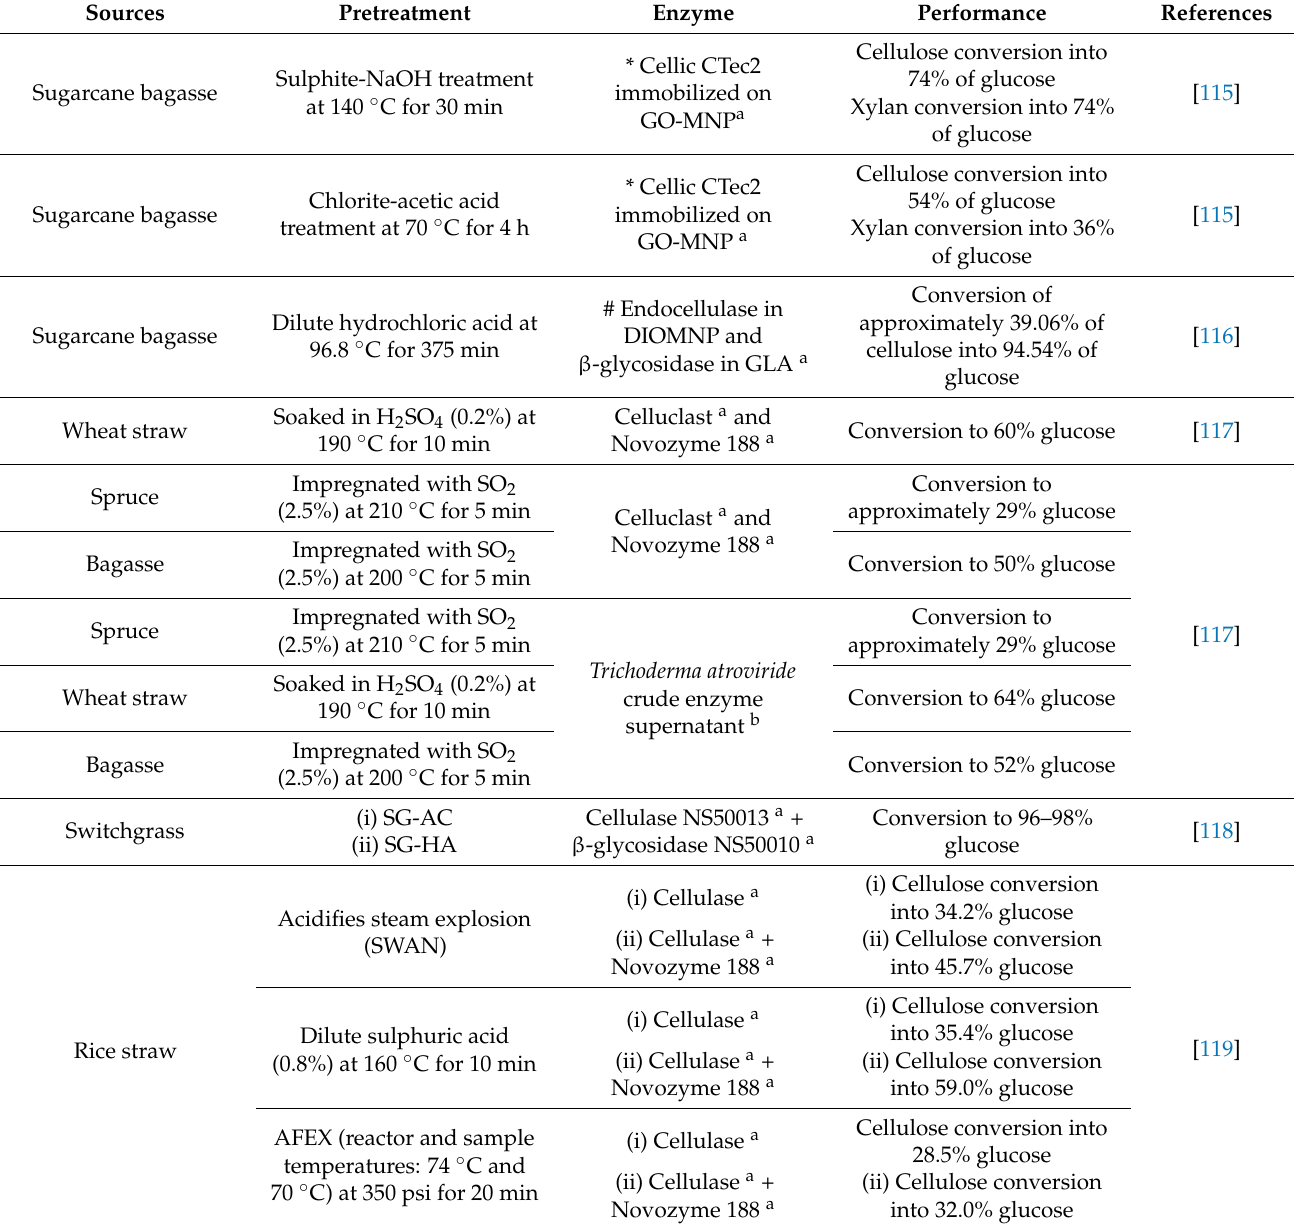
Table 3. Enzymatic hydrolysis of pretreated lignocellulosic materials using selected commercial enzymes and crude enzymes obtained directly from